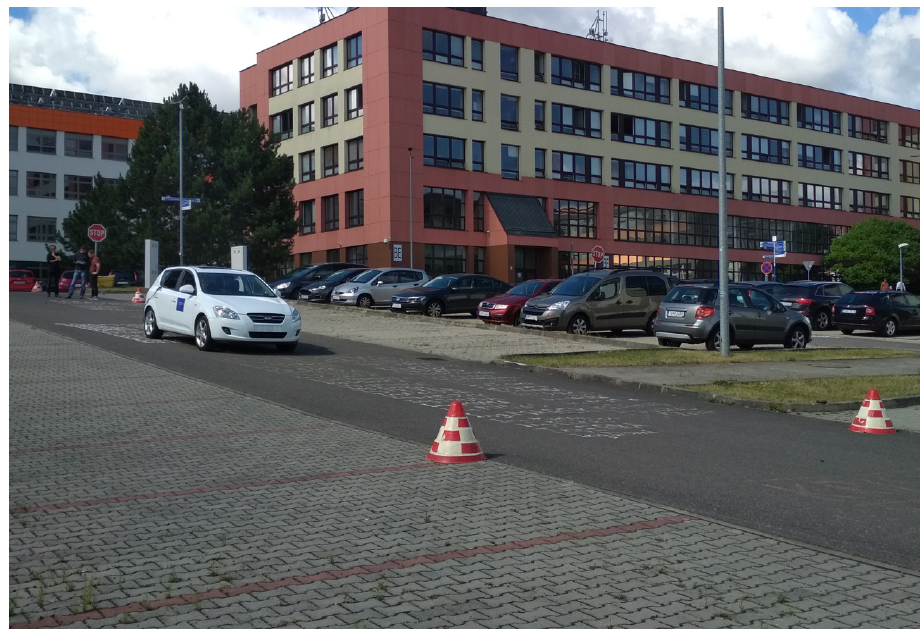
Figure 1. The laboratory tested vehicle, a Kia Ceed. Source: author.